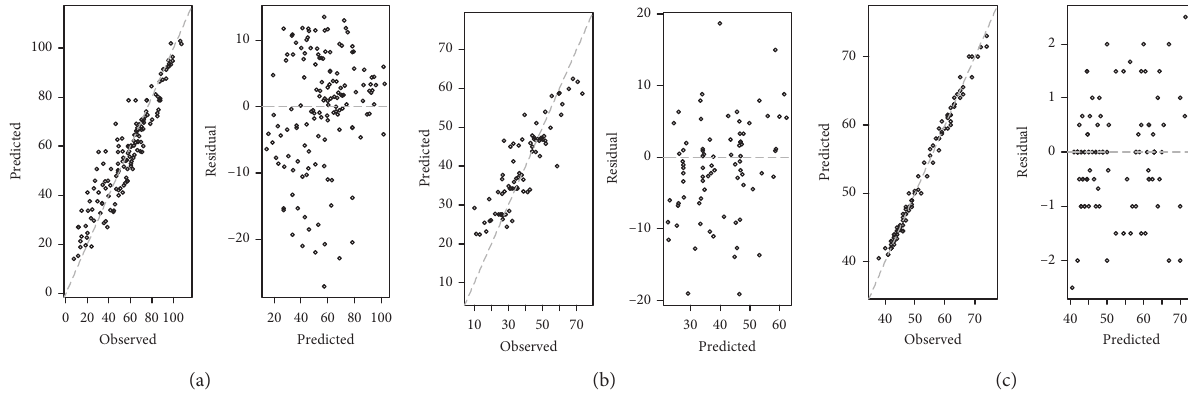
Figure 1: Left: predicted versus observed CS values for concrete datasets; right: residuals versus the predicted values. (a) Dataset 1. (b) Dataset 2. (c) Dataset 3.